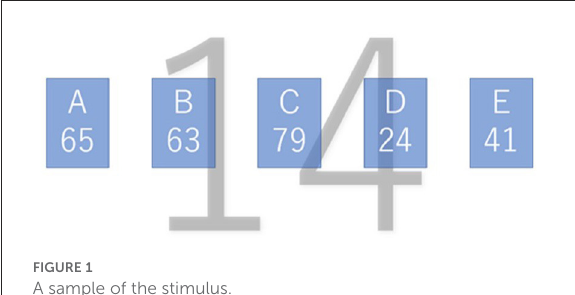
FIGURE1 A sample of the